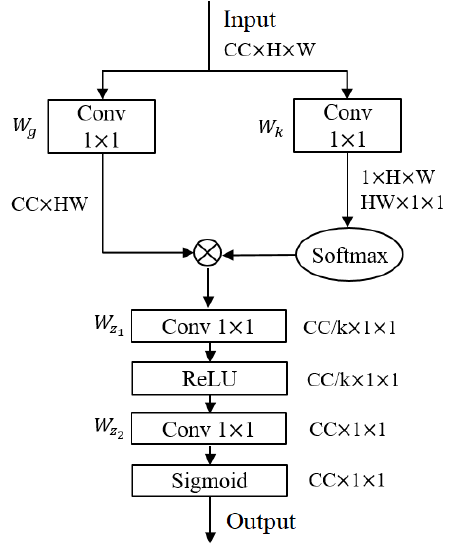
Figure 5. The architecture of class-related attention